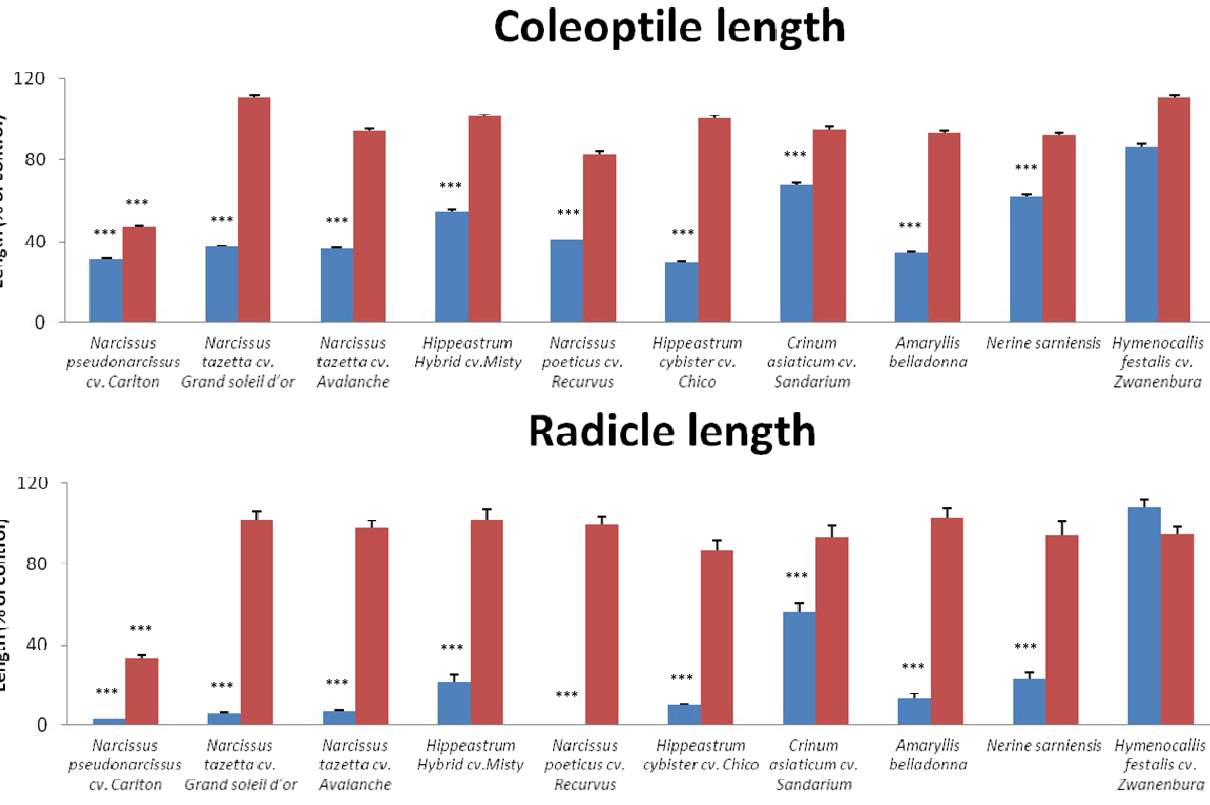
Figure 1. The effect of ten active methanol extracts on coleoptile and radical lengths of Senecio vulgaris seeds at 0.1 and 0.01 mg/mL. Data present means and standard deviations of 3 replicates. Significant differences between control and treatment are indicated as: *** p ≤